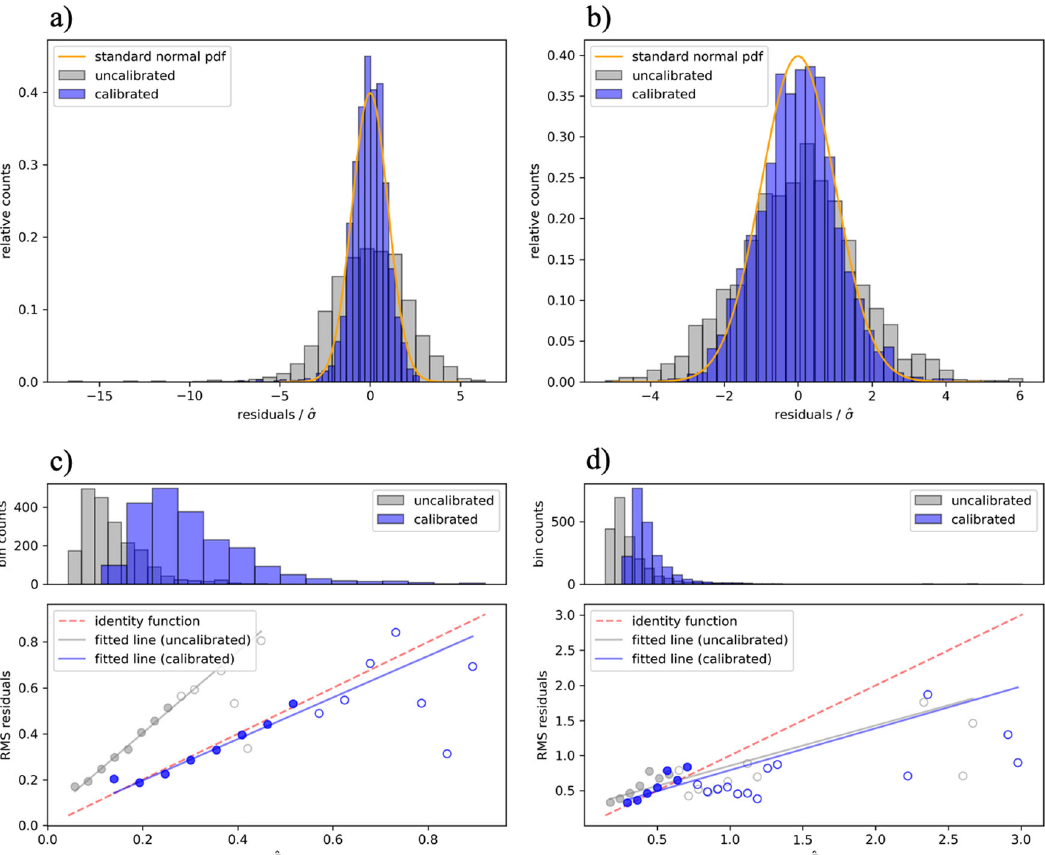
Fig. 2 Calibrated and uncalibrated r-statistic and RvE plots for GPR and linear ridge regression. Distributions of r-statistic values (top row) and RMS residual vs. ^ σ plots (bottom row) for Gaussian process regression (panels a and c ) and linear ridge regression (panels b and d ), using the diffusion dataset, shown with both uncalibrated and calibrated ^ σ values. Markers which are not fi lled in represent bins with fewer than 30 points. Statistics for each plot are summarized in Table